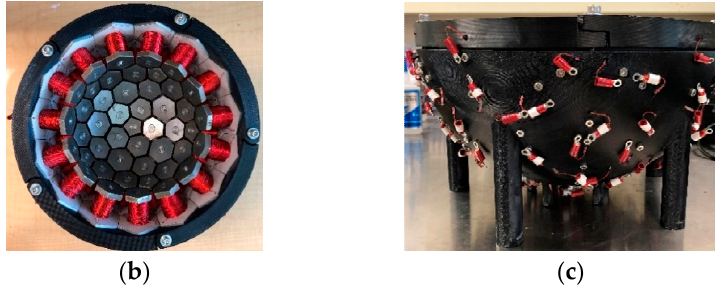
Figure 5. Stator housing: ( a ) solid model showing basic geometry; ( b ) photograph showing secured stator poles; ( c ) photograph showing external phase connections.